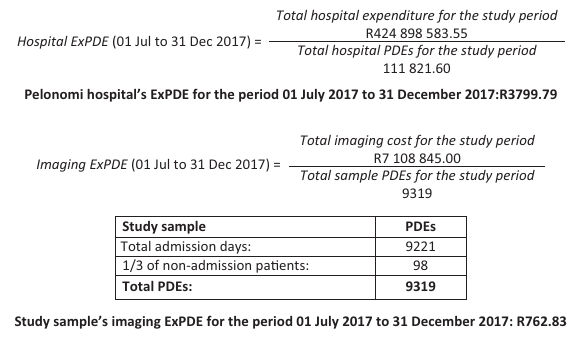
FIGURE 1: Hospital expenditure per patient day equivalent and imaging expenditure per patient day equivalent. PDE, patient-day equivalent; ExPDE, expenditure per patient-day